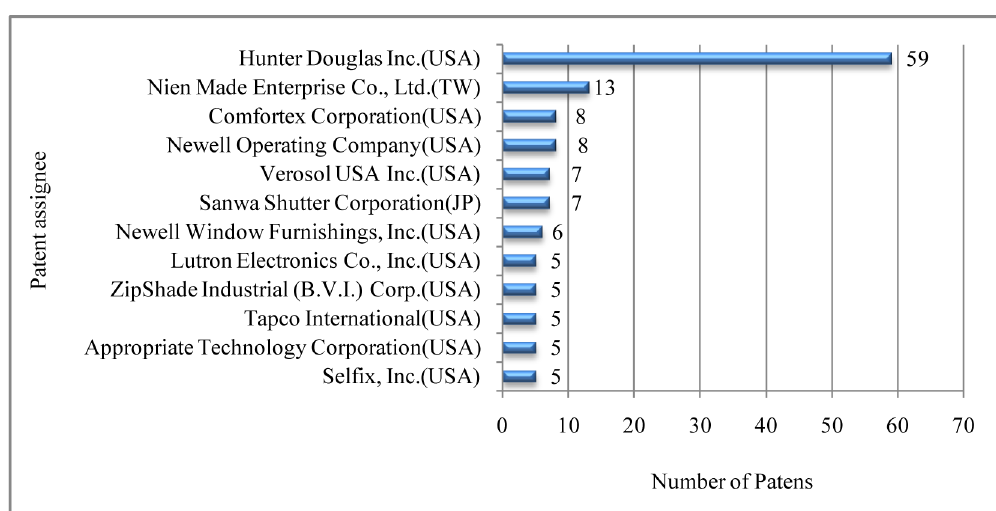
Fig. 4. Top 10 patent assignees in the technology